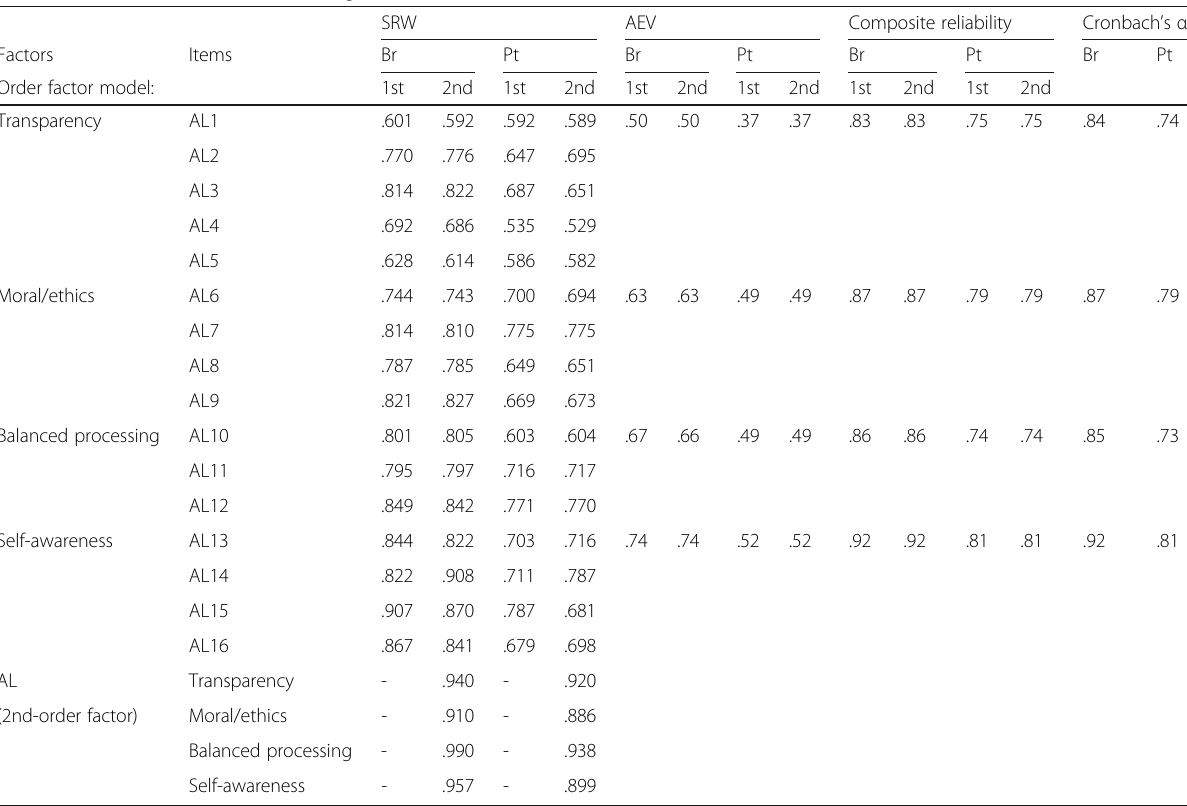
Table 3 Standardized regression weights (SRW), reliabilities, and average extracted variance (AEV) for first-order and second-order factor models ( N Brazil = 1019; N Portugal = 842) SRW AEV Factors Transparency AL1